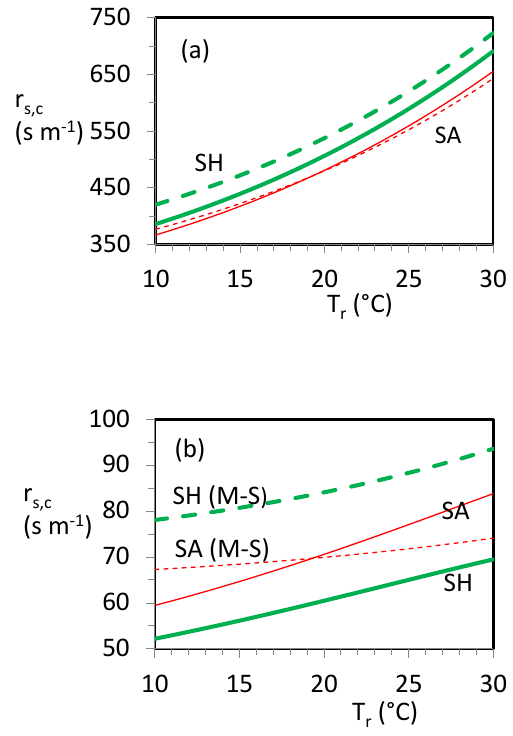
Figure 2. Variation of crop surface resistance as a function of air Fig. 2- Variation of crop surface resistance as a function of air temperature for two climatic temperature for two climatic environments – SA: semi-arid (thin environments (SA: semi-arid (thin line), SH: sub-humid (bold line), u r =2 m s -1 ) and comparison with line), and SH: sub-humid (bold line), u r = 2ms − 1 – and compar- the Matt-Shuttleworth estimate (M-S) (dotted line): (a ) K c = 0.5 and z h = 0.5 m; (b) K c = 1.1 and z h ison with the Matt–Shuttleworth estimate (M–S) (dotted line): (a) =1.5 m. K c = 0 . 5 and z h = 0 . 5m; (b) K c = 1 . 1 and z h = 1 . 5m.